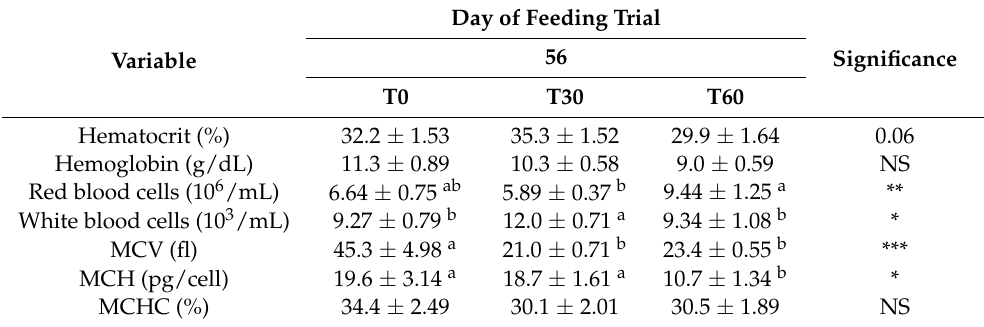
Table 5. Blood components of mixed-breed goats fed different levels of T. recurvata on day 56 of the trial. Values are means ±